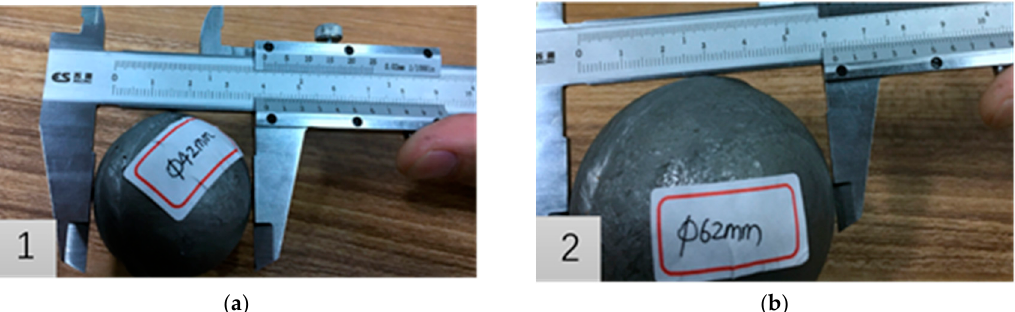
Figure 13. The outer dimensions measurement of specimen after the experiments. ( a ) Φ 42 mm; ( b ) Φ 62 mm. Table 3. Comparable analysis of steel balls outward dimensions.